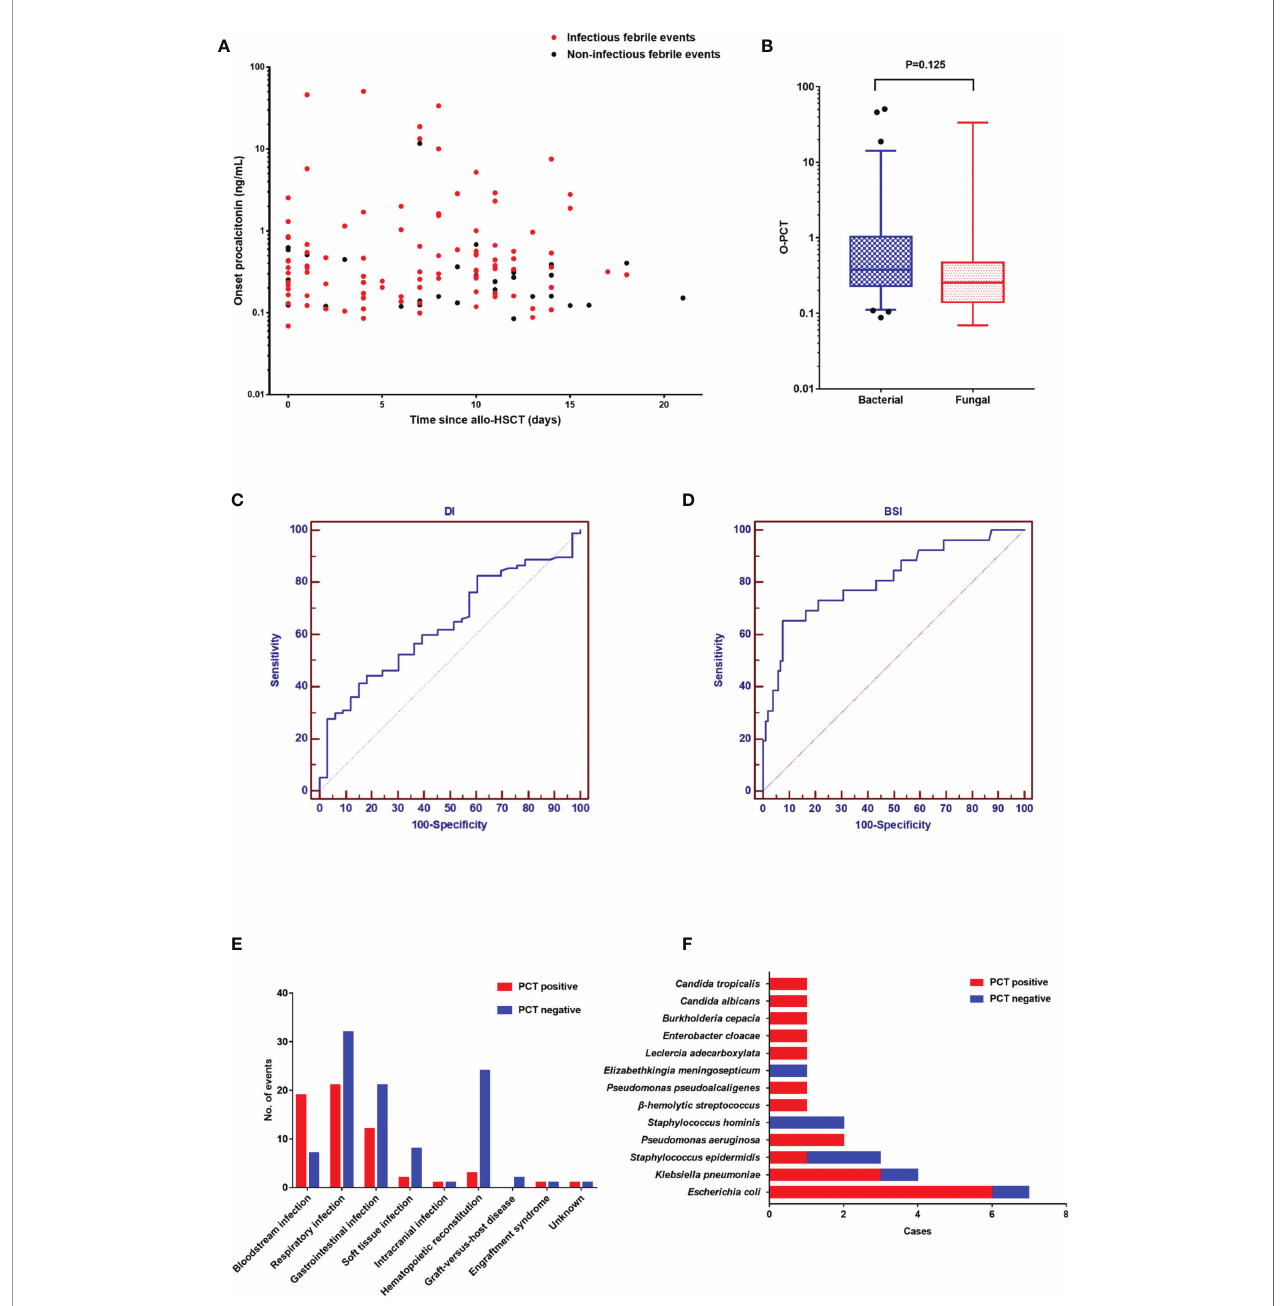
FIGURE 2 | (A). The onset value of procalcitonin in 130 febrile events in the neutropenic period after allogeneic hematopoietic stem cell transplantation. (B) Comparison of the onset PCT value among the three groups: fungal infection, bacterial infection, and noninfectious events. (C) The diagnostic value of procalcitonin for documented infection. (D) The diagnostic value of procalcitonin for documented infection. (E) The diagnosis of 130 febrile events. (F) The spectrum of pathogens in 26 positive blood